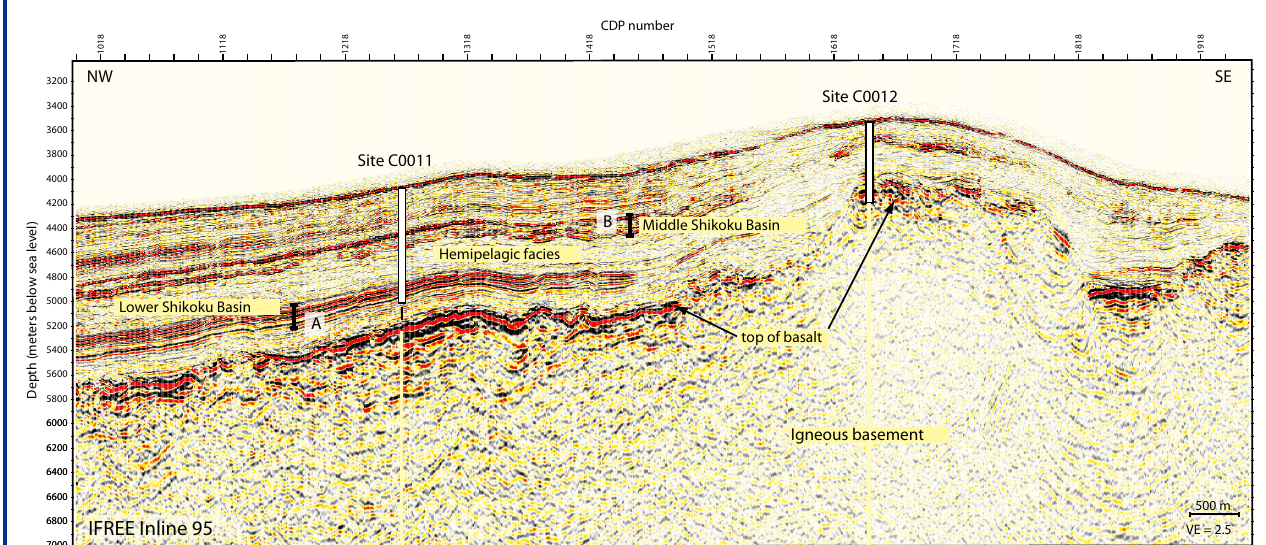
Figure 2. Portion of IFREE 3-D seismic reflection Line 95 showing Sites C0011 and C0012. Depth section corrected during Expedition 322 after adjustments to velocity model following acquisition of LWD data at Site C0011. VE = vertical exaggeration, Ι marks distinctive intervals of high amplitude reflectors ([A] at ~700 mbsf to ~900 mbsf and [B] at ~350 mbsf to ~500 mbsf at the location of Site